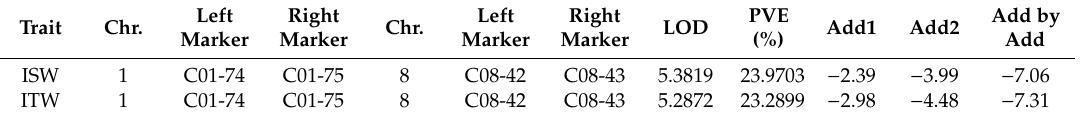
Table 2. Digenic epistatic QTLs of allelopathy analyzed by inclusive composite interval